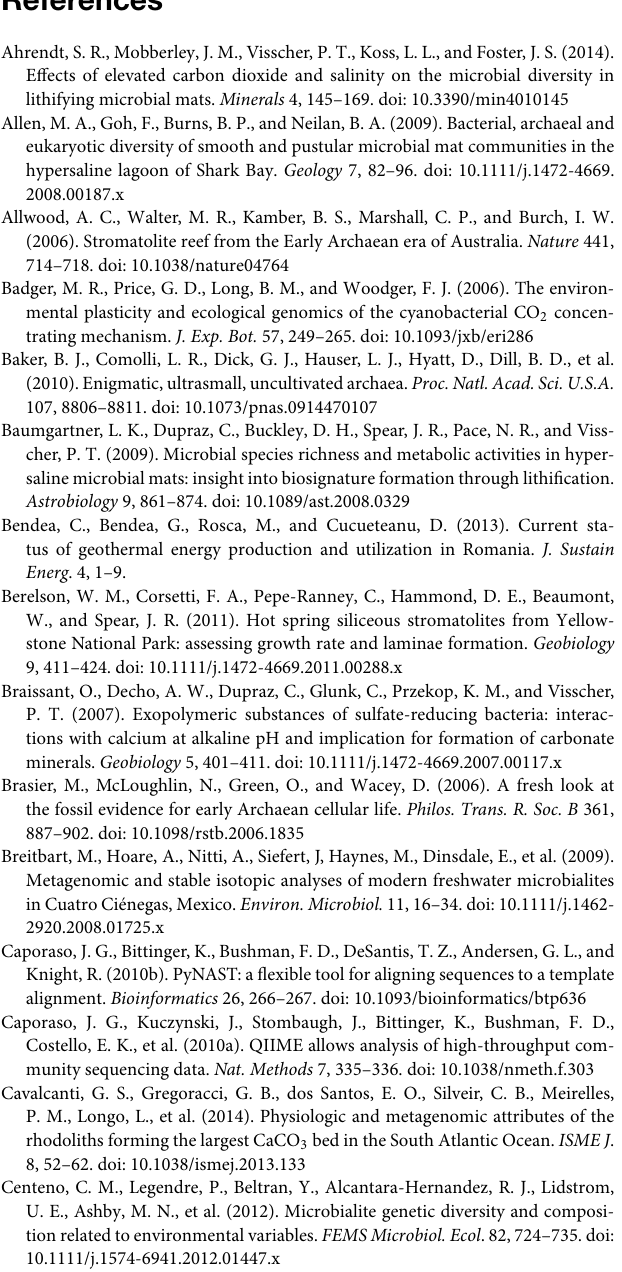
Supplementary Figure S2 | The phylogenetic placement of OTUs using the Maximum Likelihood algorithm in Mega 5 (Tamura et al., 2011) relative to manually selected 16S rRNA gene sequences from GenBank (NCBI database). Supplementary Figure S3 | Rarefaction curves for the C32, C49 and C65 microbialite samples from Ciocaia. Supplementary Figure S4 | Relative abundance of gene counts in the C32, C49 and C65 microbialite samples from Ciocaia for selected functional KEGG pathways inferred from 16S rRNA gene data using PICRUSt (Langille et al.,